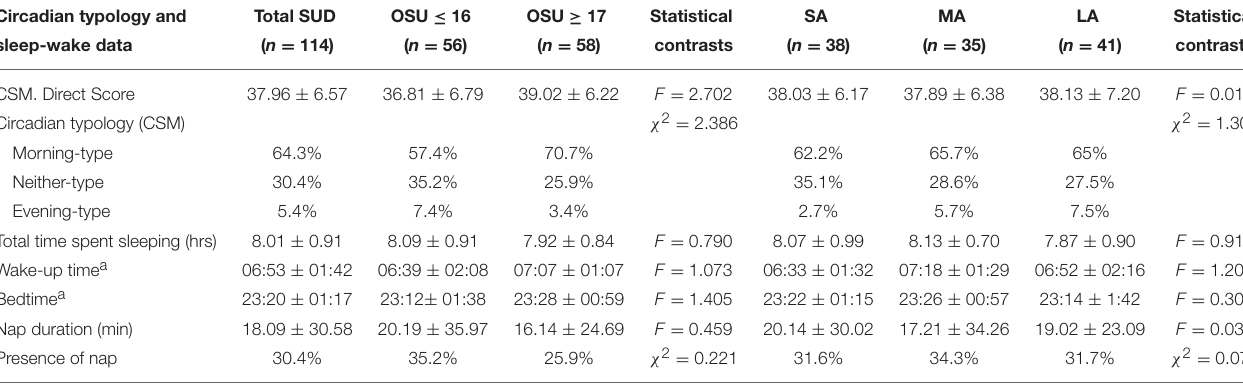
TABLE 3 | Circadian typology and sleep-wake data for the whole SUD sample and all their subgroups. Circadian typology and Total SUD OSU ≤ 16 OSU ≥ 17 Statistical SA MA LA Statistical sleep-wake data ( n = 114) ( n = 58)